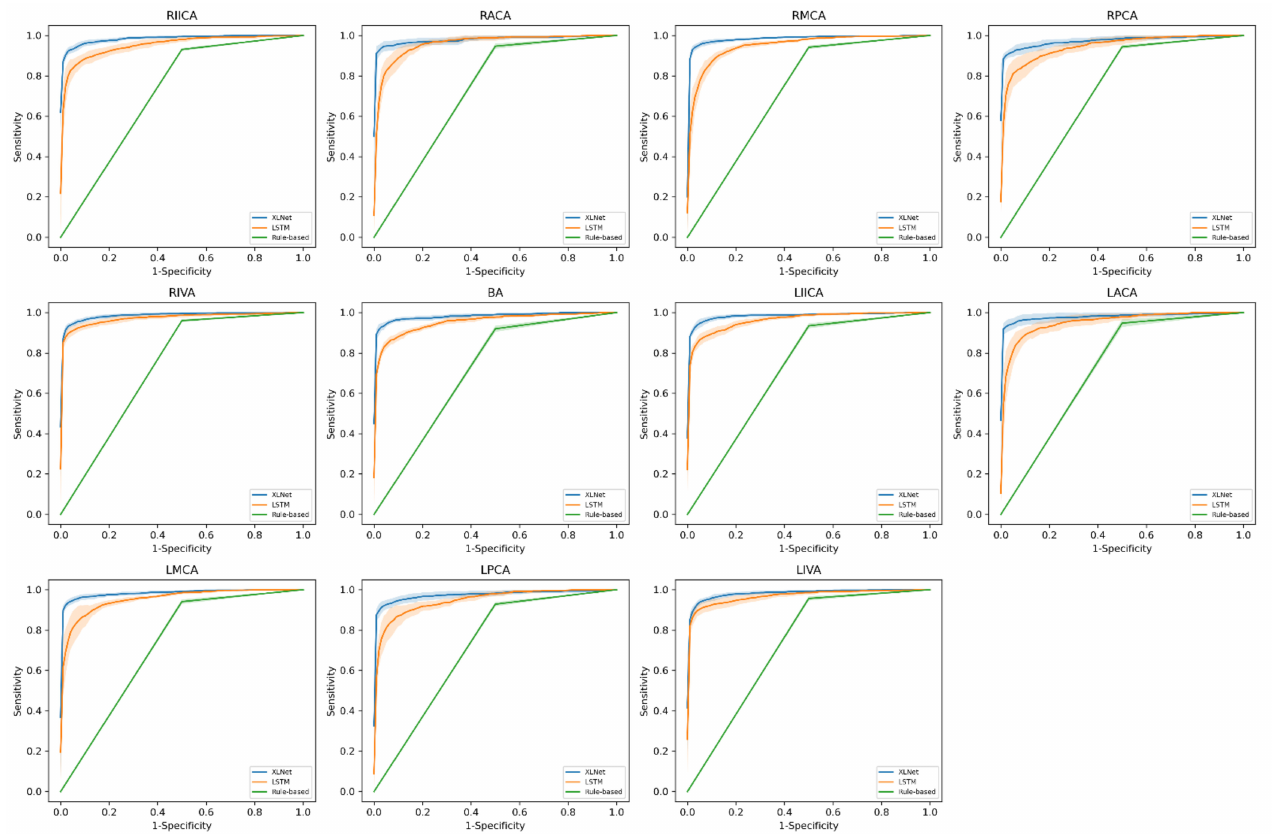
Figure 3. Comparison of the receiver operating characteristic curves (ROC) in stenosis detection tasks obtained by the rule-based model, the long short-term memory (LSTM) model, and the XLNet model with the internal test dataset. Each plot represents stenosis detection performance on each artery. The XLNet model clearly demonstrates superior performance with consistent larger area under the curve results compared with those of the LSTM